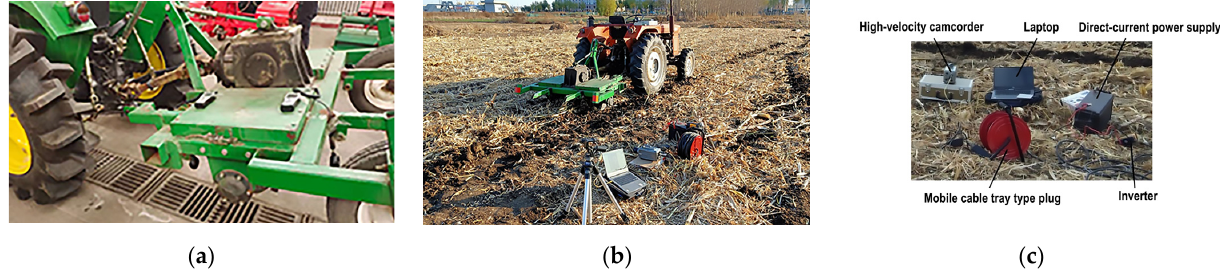
Figure 7. Apparatus of field experiment: ( a ) actual installation of air volume meter; ( b ) experimental devices; ( c ) electrical device connection.